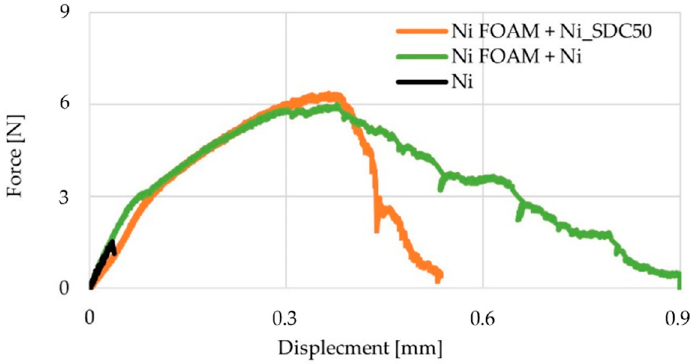
Figure 11. Tensile strength tests for cathodes consisting of: (black line) only Ni layer without Ni foam, (green line) Ni layer with Ni foam, and (orange line) Ni-50% SDC layer with Ni foam.